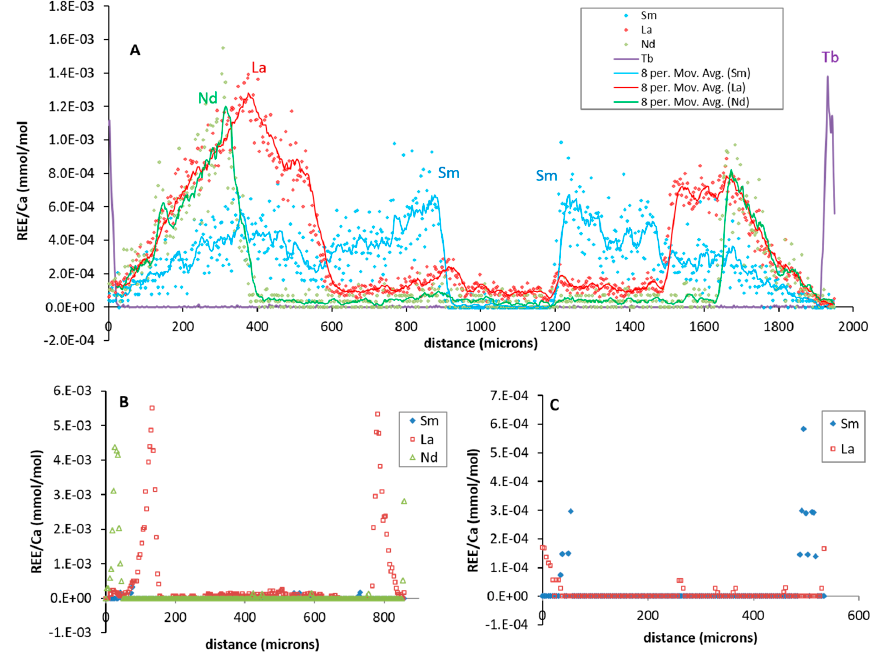
Figure 3. Example of rare earth elements (REE)/Ca analytical profiles shown through individual calcite crystals for DC-1 ( a ), DC-2 ( b ), and DC-3 ( c ). For additional profiles see Figure S1.